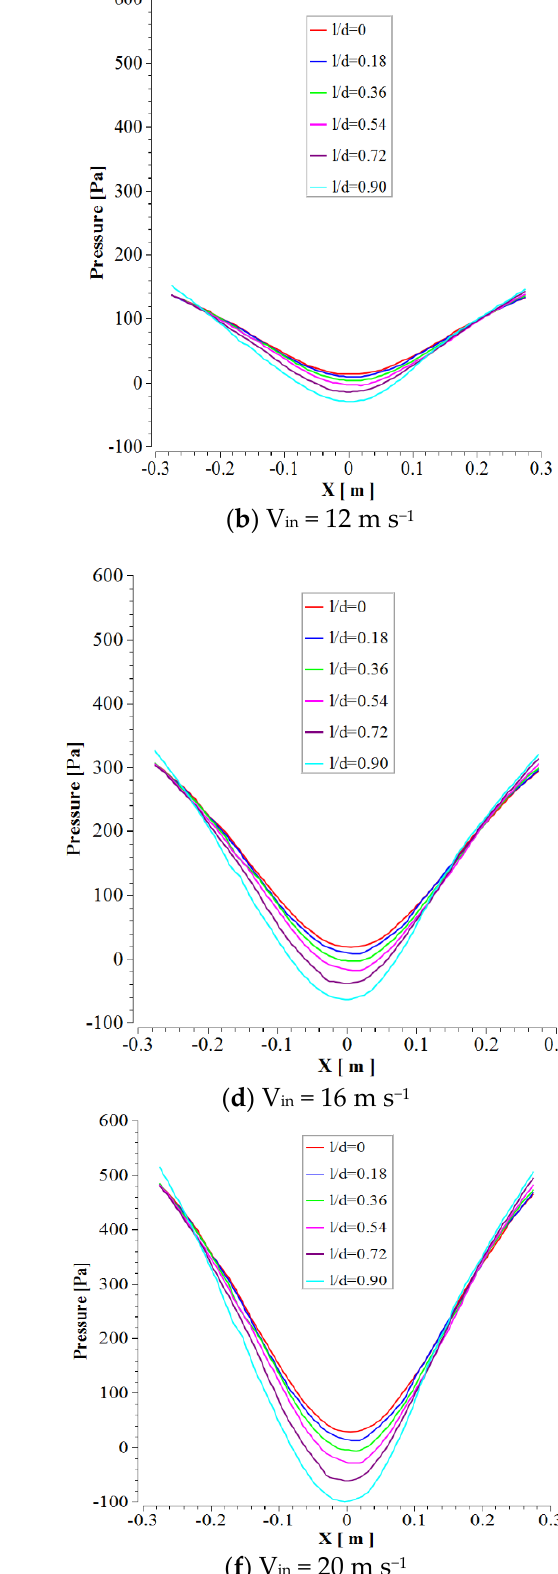
Figure 16. The variation of static pressure graphs of 6 various cyclone cylinder heights in various inlet velocities. Zhou et al. indicated that increasing the inlet velocity increases the pressure drop. In their work, four levels of inlet velocities, including 10, 15, 20, and 25 m s −1 were evaluated [29].